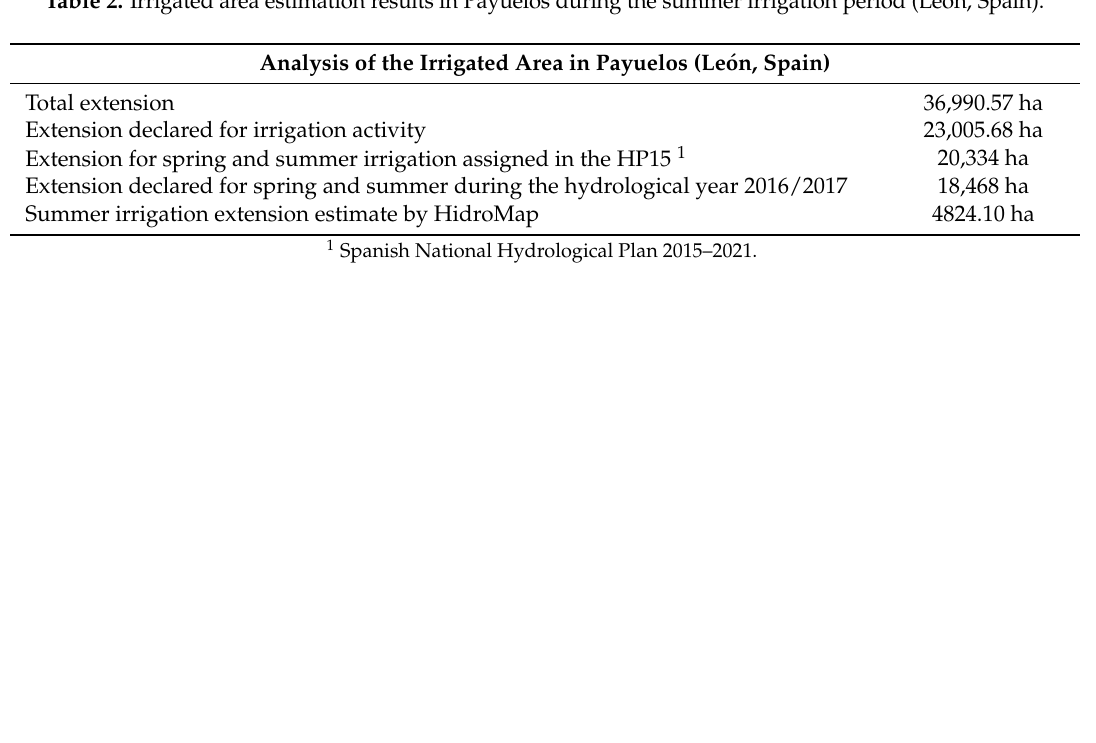
Table 2. Irrigated area estimation results in Payuelos during the summer irrigation period (Le ó n,